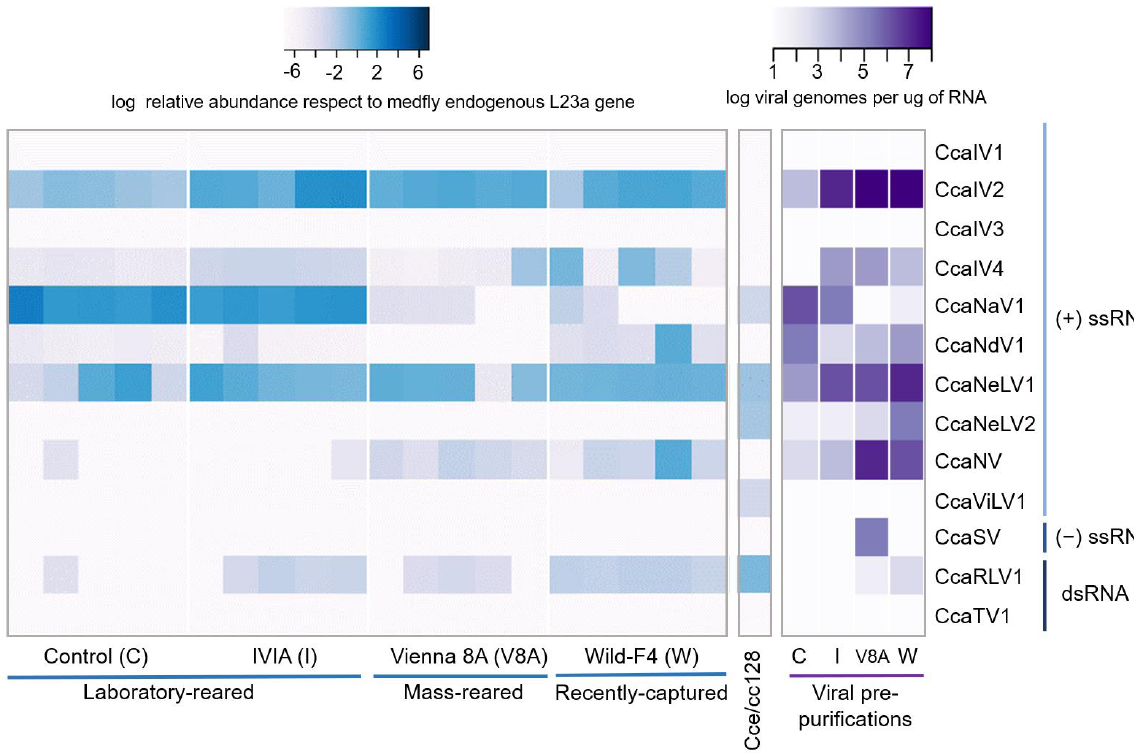
Figure 2. Relative virus abundance in different medfly strains and in a cell line. Heatmap of the relative abundance of the 13 medfly RNA viruses in five pupae (one pupa per column) from two laboratory-reared strains (control (C) and IVIA (I)), one mass-reared strain (Vienna 8A (V8A)), and one recently captured strain (Wild-F4 (W)), in the Cce/cc128 medfly cell line and in four viral pre- purifications obtained from each of the four previously mentioned strains. For the single pupae and the Cca/cc128 cell line, color plots represent values of viral relative abundance, calculated as viral RNA genomes relative to the expression of the mitochondrial L23a gene of medfly. For the viral pre-purifications, color plots represent viral abundance, calculated as viral genomes per µ g of RNA using a standard curve with known viral